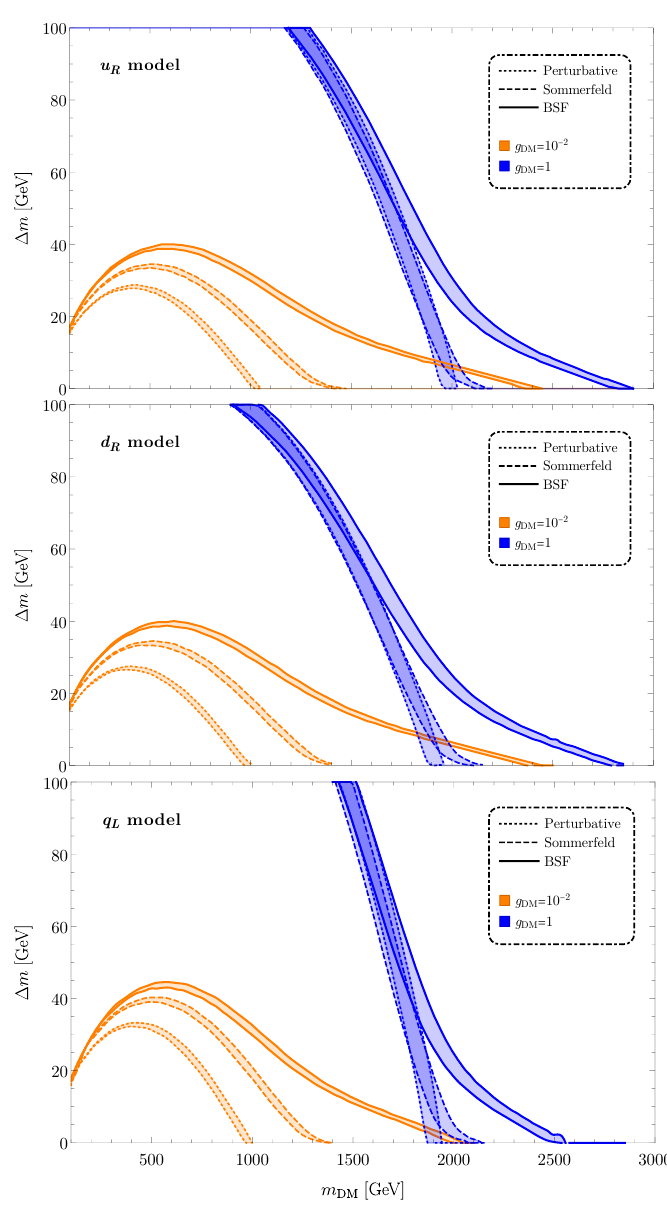
Figure 4. Mass splitting ∆ m = m X − m DM vs. DM mass ( m DM ) in the three models here considered: u (top), d (middle), and q (bottom). The bands correspond to the observed DM R R L relic density within a 5 σ uncertainty according to [1]. We show the results by progressively including the perturbative contribution only (dotted lines), Sommerfeld corrections (dashed lines) and further inclusion of formation and decay of bound states of the colored triplet scalars (solid lines). The two-color scheme refers to two benchmark values of the Yukawa coupling: g = 1 (blue) and DM g DM = 10 − 2